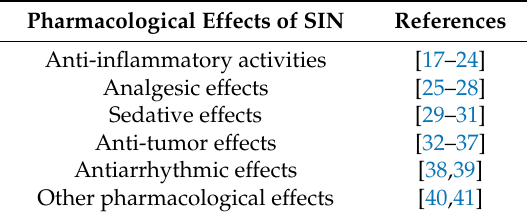
Table 1. The pharmacological effects of sinomenine (SIN) along with